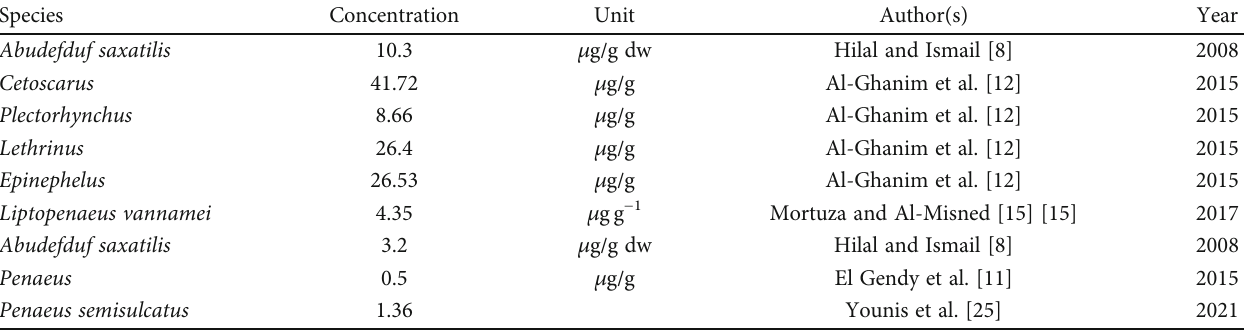
Table 6: Bioaccumulation of cobalt and chromium reported from the Red Sea.